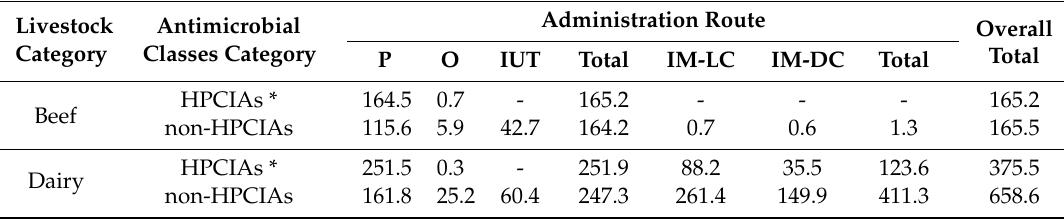
Table 6. Average yearly consumption of HPCIAs (DCD vet / year × 10 − 3 ) per individual administration route on beef and dairy farms. P = parenteral, O = oral, IUT = intrauterine, IM-LC = intramammary lactating cow, IM-DC = intramammary dry cow.